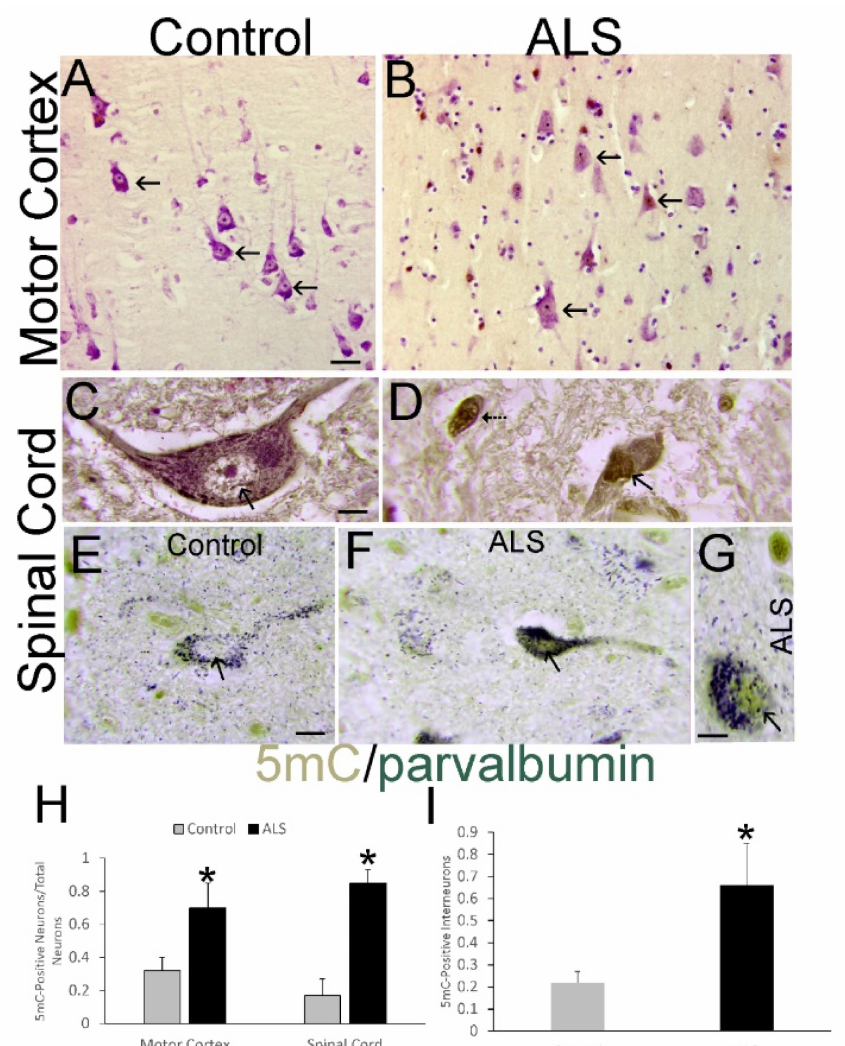
Figure 8. Upper MNs and spinal cord MNs and interneurons undergo hypermethylation in human ALS. ( A ) Layer V pyramidal neurons in control motor cortex (arrows) have low nuclear 5mC IR (brown). ( B ) In ALS motor cortex, numerous layer V pyramidal neurons (arrows) have nuclear 5mC IR (brown). ( C ) Spinal cord MNs in controls have chromatin threads (arrow) decorated with 5mC IR (brown) against a negative nucleoplasm. ( D ) Spinal cord MNs in ALS cases have shrunken nuclei that are strongly positive throughout for 5mC IR (arrow, brown) and cell bodies with somatodendritic at- trition. These cells are discernible as attritional MNs because of the marginalized Nissl substance [62]. Other cells (hatched arrow) could be residual MNs or interneurons. ( E ) Interneurons, identified by parvalbumin (arrow, green/black) plus 5mC (brown), show scant DNA methylation IR in controls. ( F,G ) In ALS cases, parvalbumin (green/black, arrow) colocalizes with 5mC (brown). Interneuron in ( G ) is shown at higher magnification. Scale bars: ( A ) (same for ( B )), 30 µ m; ( C ) (same for ( D )), 10 µ m; ( E ) (same for ( F )), 10 µ m; ( G ), 5 µ m. ( H ) Counts (mean ± SD) of motor cortical pyramidal neurons and spinal MNs with nuclear IR for 5mC in control ( n = 6) and ALS ( n = 8) cases. * p < 0.01, motor cortex; * p < 0.001, spinal cord. ( I ) Counts (mean ± SD) of parvalbumin-positive spinal cord interneurons with nuclear IR for 5mC in control ( n = 6) and ALS ( n = 8) cases. * p <